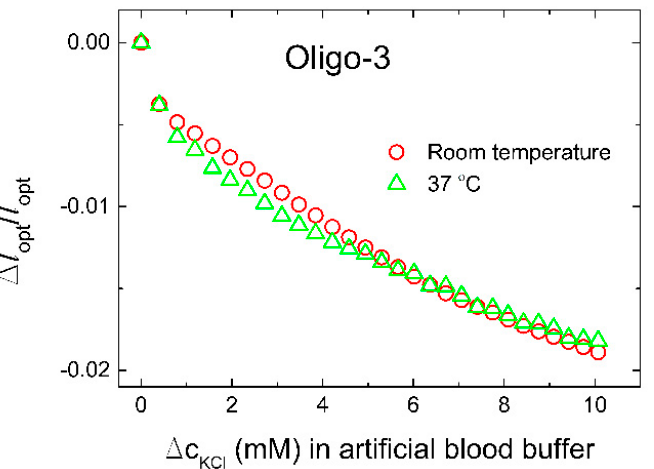
Figure 6. Change in the optical length of the sensor in artificial blood fluid (Tris-HCl with 140 mM NaCl, 2.35 mM CaCl 2 , 0.85 mM MgCl 2 , 42.5 g/L BSA) at room temperature and human body temperature (37 °C).